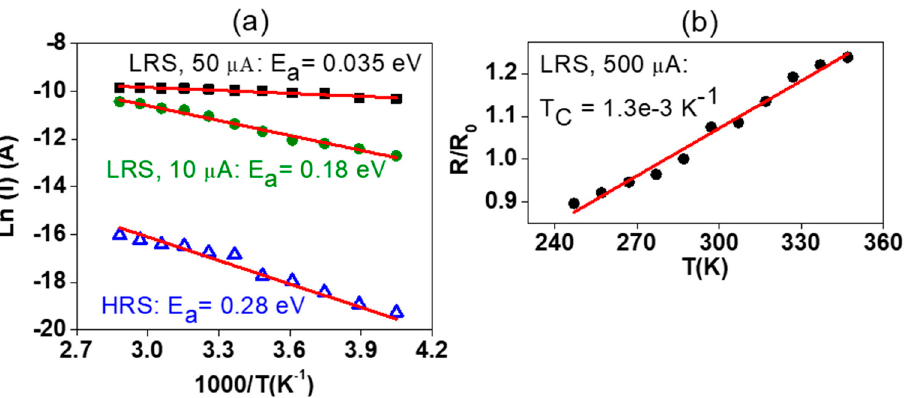
Figure 6. Arrhenius plots with corresponding fits (red lines) of the HRS (blue triangles) and the different LRS at CC of 10 µA (green circles) and 50 µA (black squares) ( a ), linear fit with respect to temperature (red line) of the LRS at CC of 500 µA (black circles) ( b ).